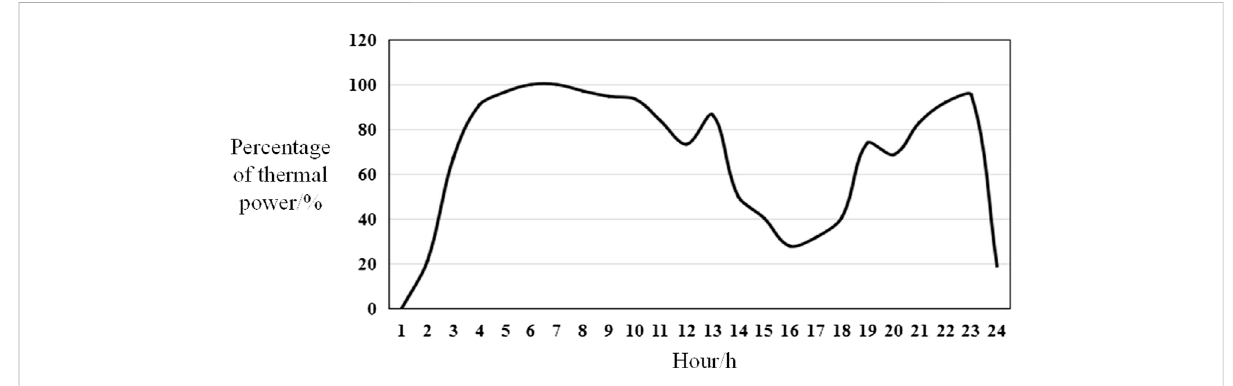
FIGURE 3 Percentage of thermal power in the electricity distribution network during the dispatch